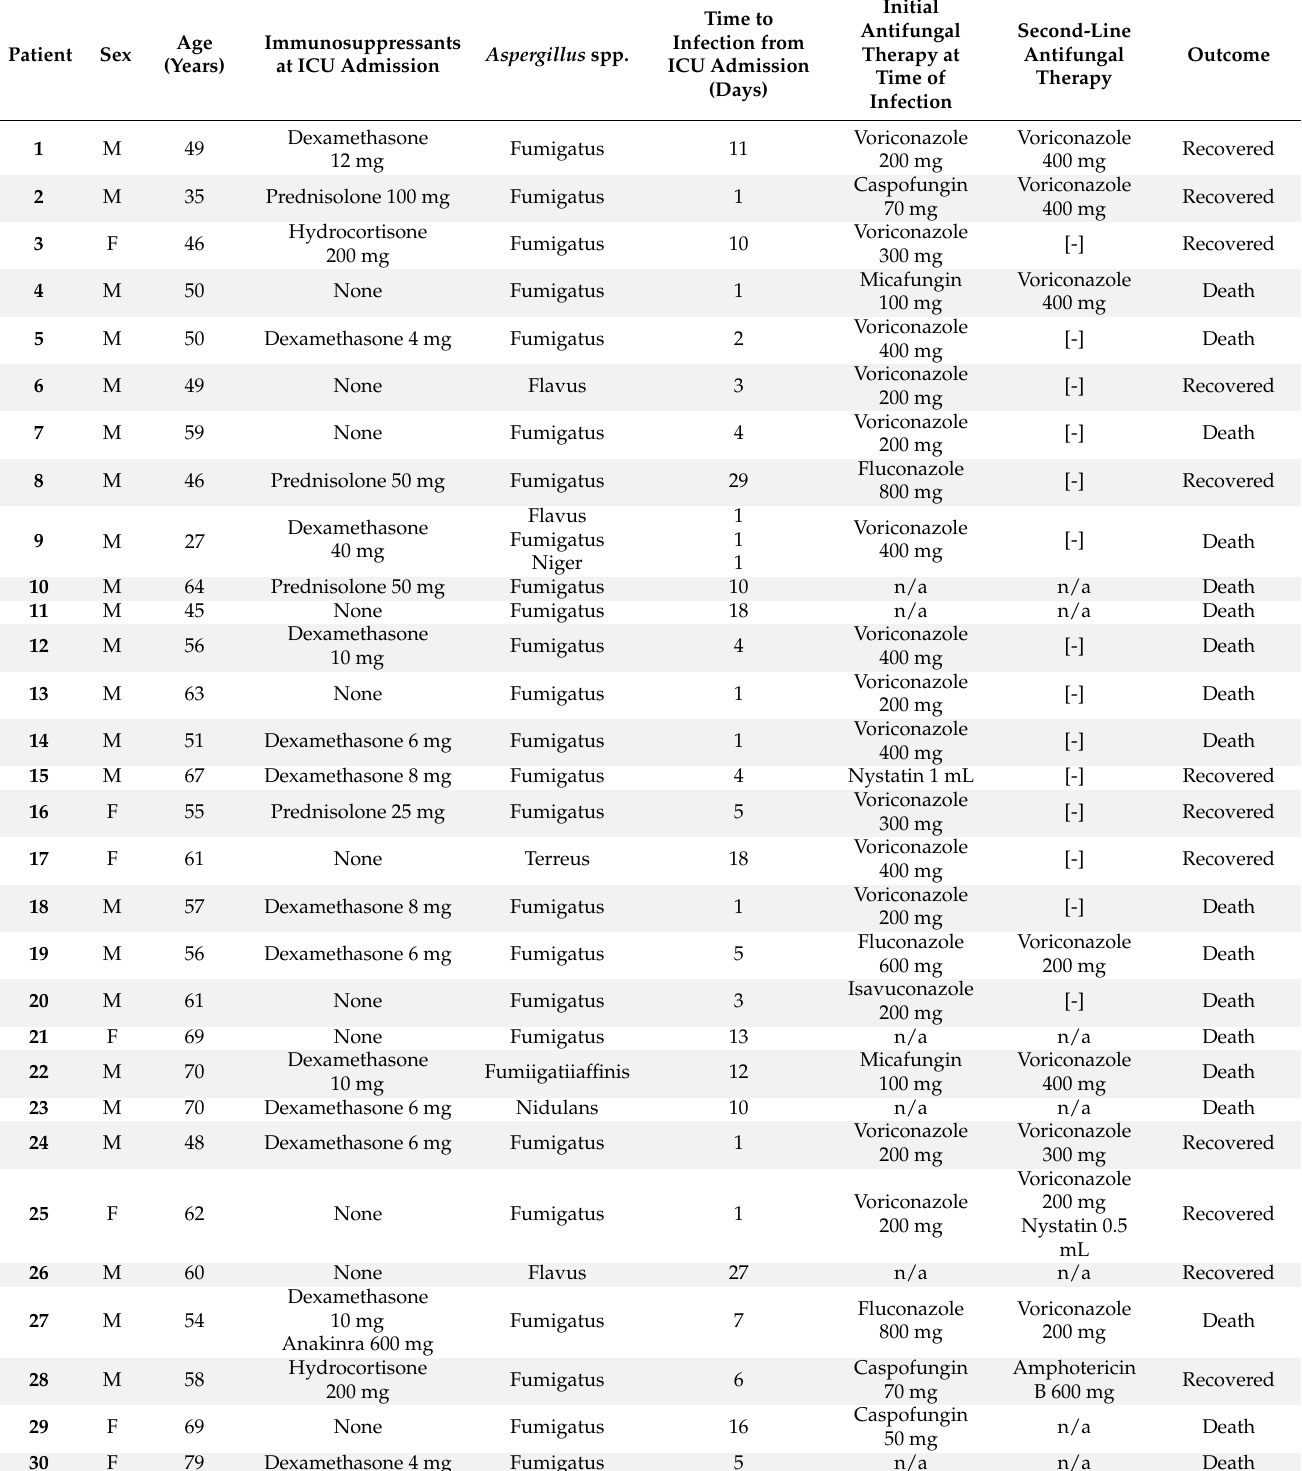
Table 2. Overview of baseline immunosuppressive medication, pathogen prevalence, time to infec- tion, antifungal therapy, and outcome by patient. n/a refers to data not available in medical records; [-] indicates no use of second-line antifungal